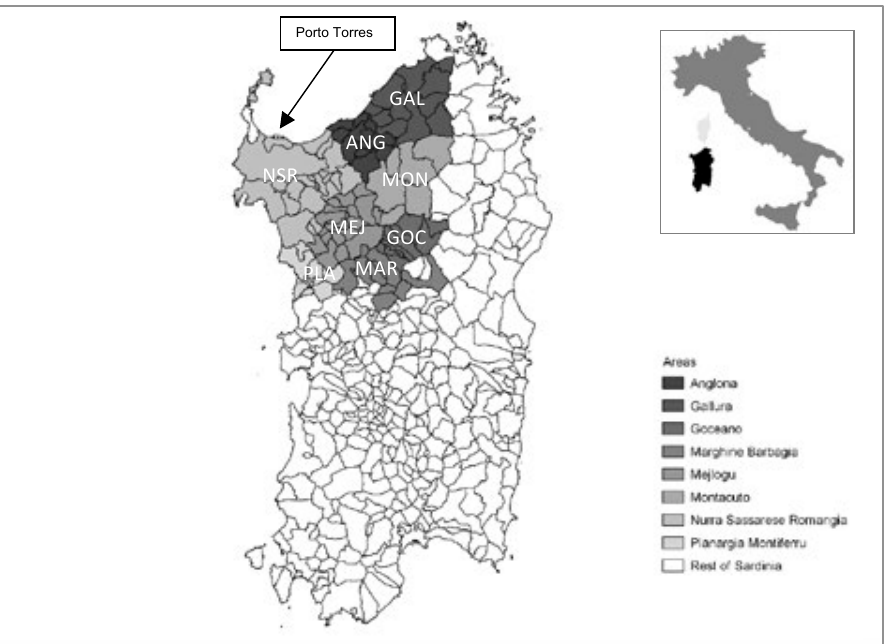
Figure 1. The area under study, Sardinia, Italy (municipal administrative level)